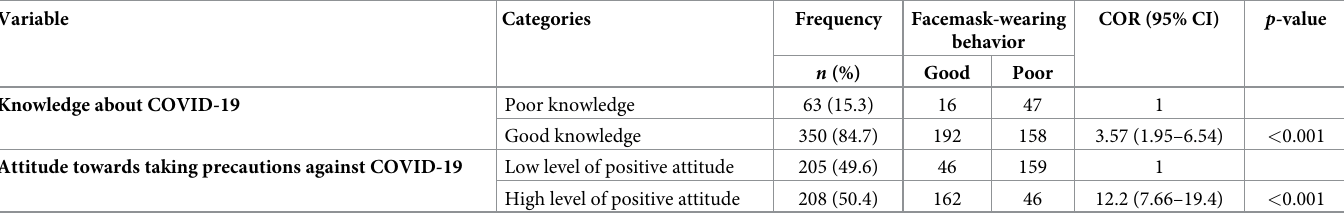
Table 3. Knowledge- and attitude-related factors and bivariable analysis with facemask-wearing behaviors among bank workers in Dessie City, Ethiopia, January 2021.